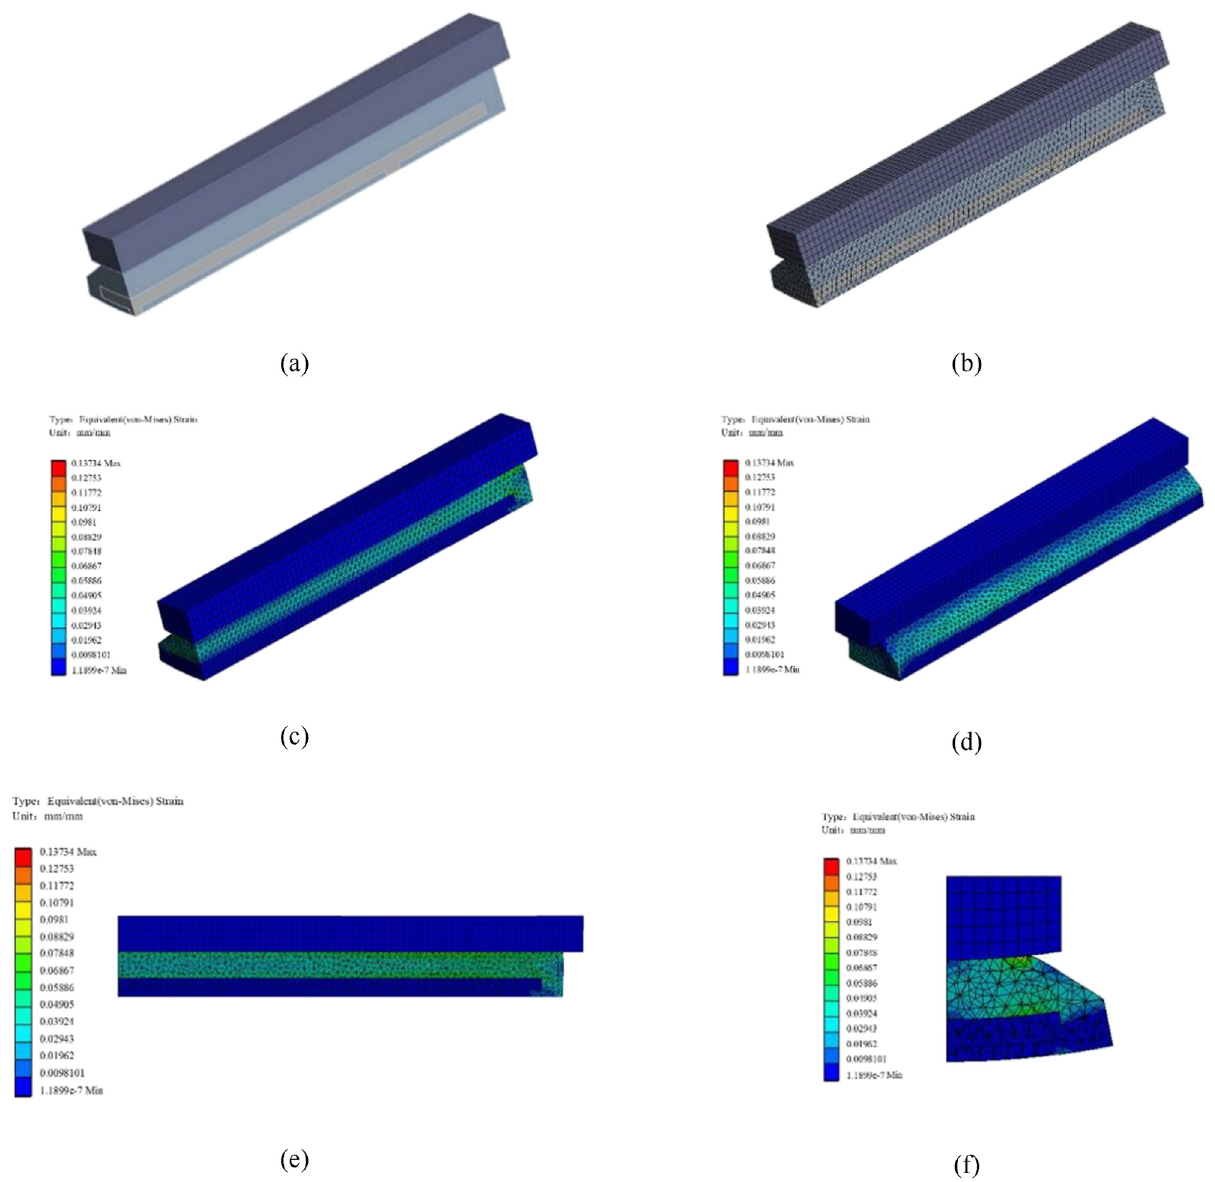
Figure 8: Statics analysis results for the rubber stave structure: ( a ) rubber stave structure, ( b ) rubber stave grid structure, ( c ) strain state inside the rubber stave, ( d ) strain state outside the rubber stave, ( e ) axial strain state, and ( f ) radial strain